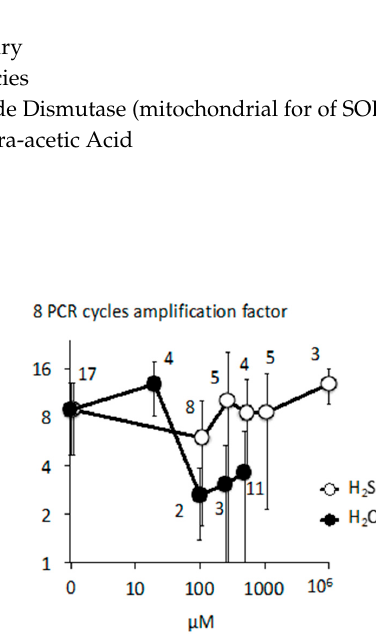
Figure A1. Quantitation of mitochodrial DNA damage: DNA was prepared from CHO cells exposed to Na 2 S (H 2 S) or H 2 O 2 . qPCR of samples compared with that of a known amount of target sequence allowed absolute quantitation. This quantitative measurement was made either directly with CHO DNA preparation or after eight cycles of a long PCR amplifying a 8Kb fragment of mitochondrial DNA (2976–11031) including the qPCR target sequence (6744–6918). Therefore, after the long PCR the theoretical amplification factor of the mtDNA target sequence is 64 times. The graph represents the experimental amplification factor ( Y axis) when cells were exposed to increasing concentrations ( X axis) of H 2 S (empty symbols) or H 2 O 2 (filled symbols). The number of experiments (independent treatment with H 2 O 2 or H 2 S) is indicated. A log scale is used for both axes with following modifications: H 2 S values are represented with X values 10% higher than reality, this allows distinction of error bars, the 10 6 value (1M) Na 2 S is represented as if 10 4 .